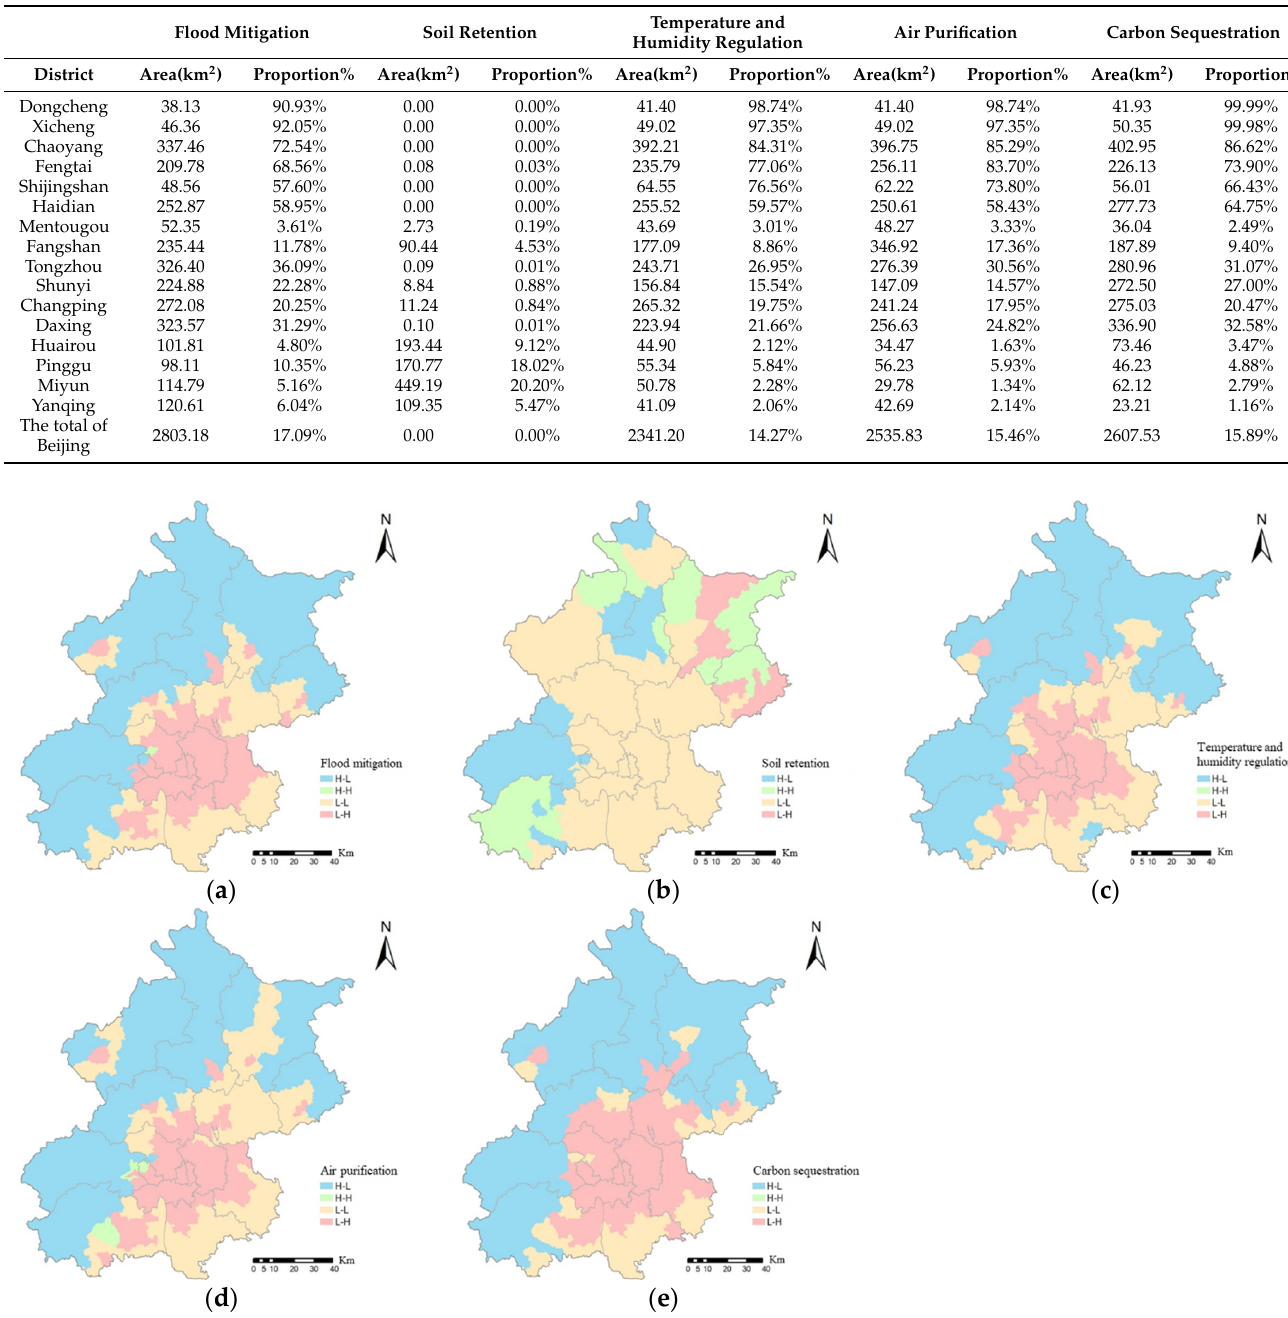
Table 4. Statistical table of the first priority area of each ES carrying capacity improvement in each district.